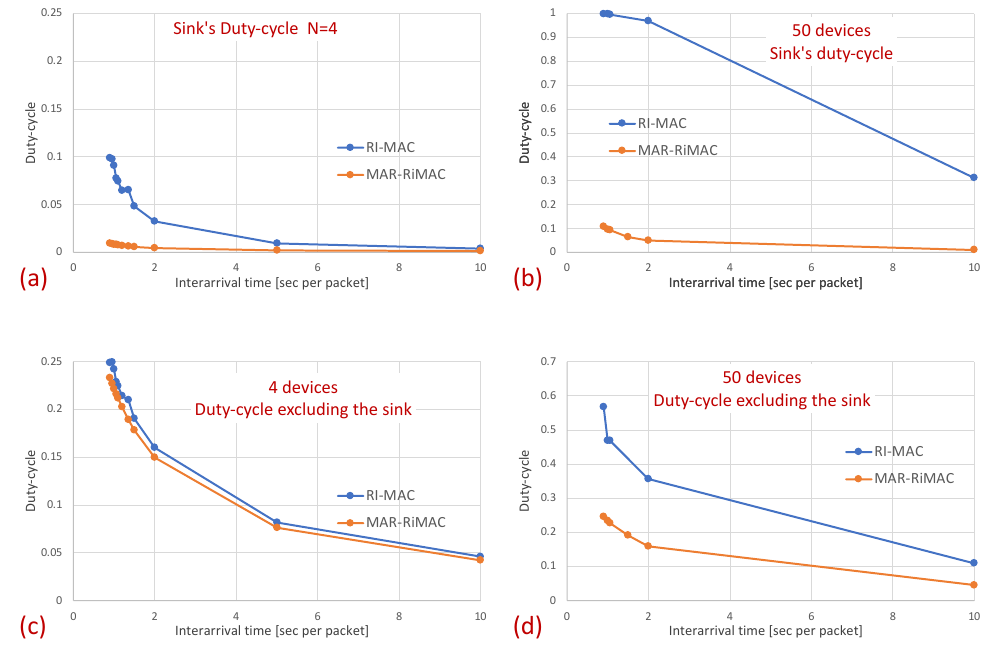
Figure 12. Hidden-terminal topology: ( a ) The sink’s mean duty cycle for four devices. ( b ) The sink’s mean duty cycle for 50 devices. ( c ) The mean duty cycle excluding the sink for four devices. ( d ) The mean duty cycle excluding the sink for 50